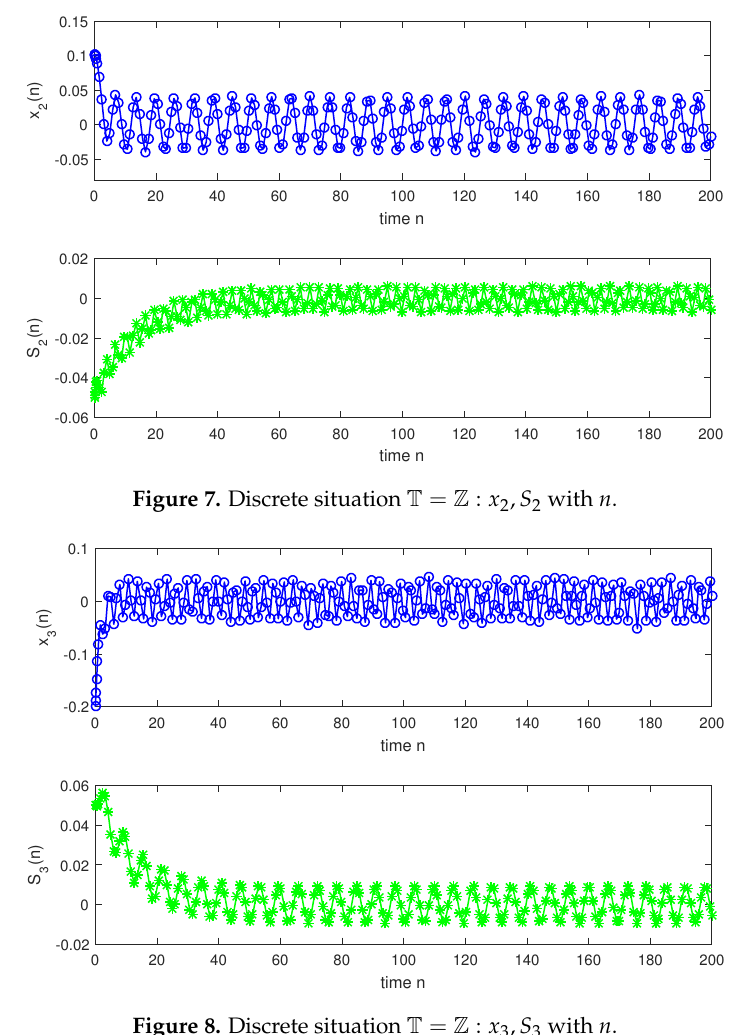
Figure 8. Discrete situation T = Z : x 3 , S 3 with n .